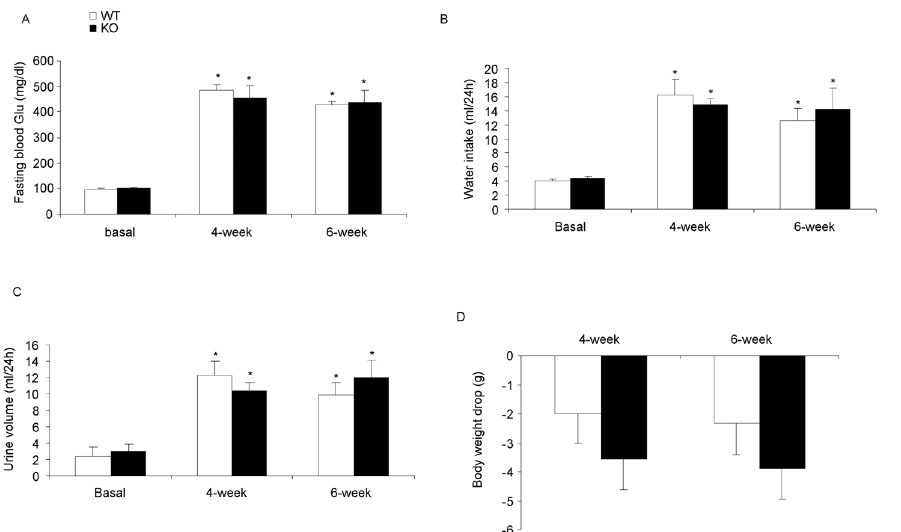
Figure 1. Evaluation of the onset of diabetes in mPGES-1 WT and KO mice. (A) Fasting blood glucose. (B) Water intake. (C) Urine volume. (D) Body weight changes. N=6–9 in each group. * p , 0.05 vs. basal. Data are mean 6 SE.